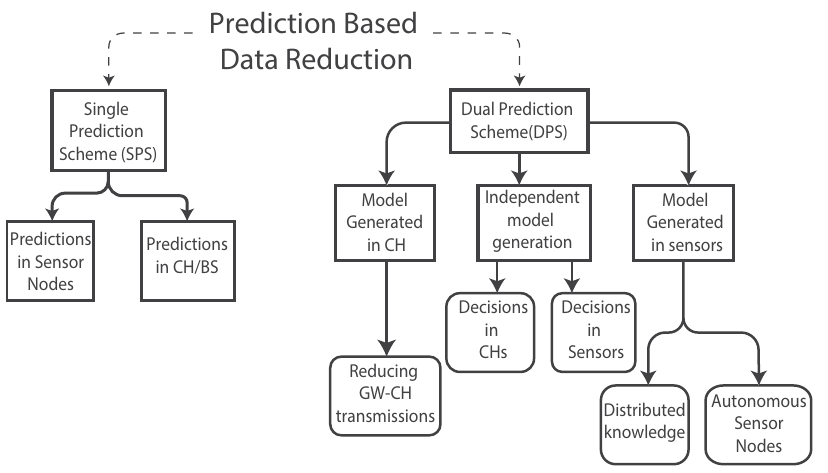
Figure 10. Taxonomy of the architectures that use predictions for data reduction